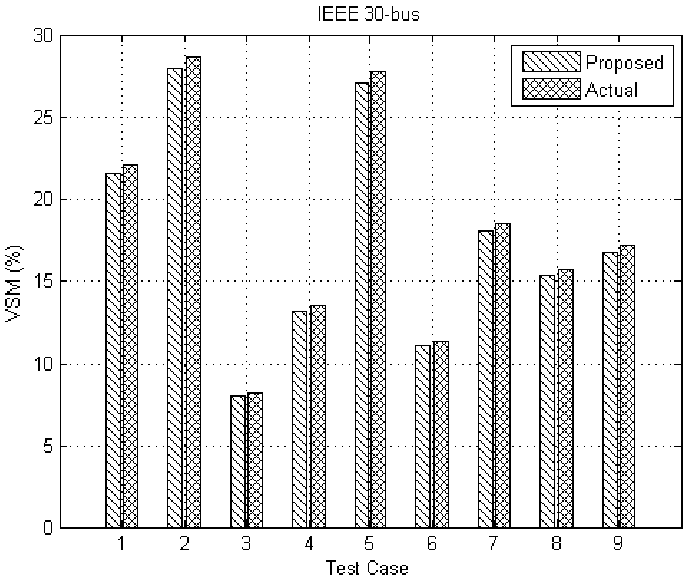
Figure 12. Estimation of system VSM for IEEE 30-bus model.